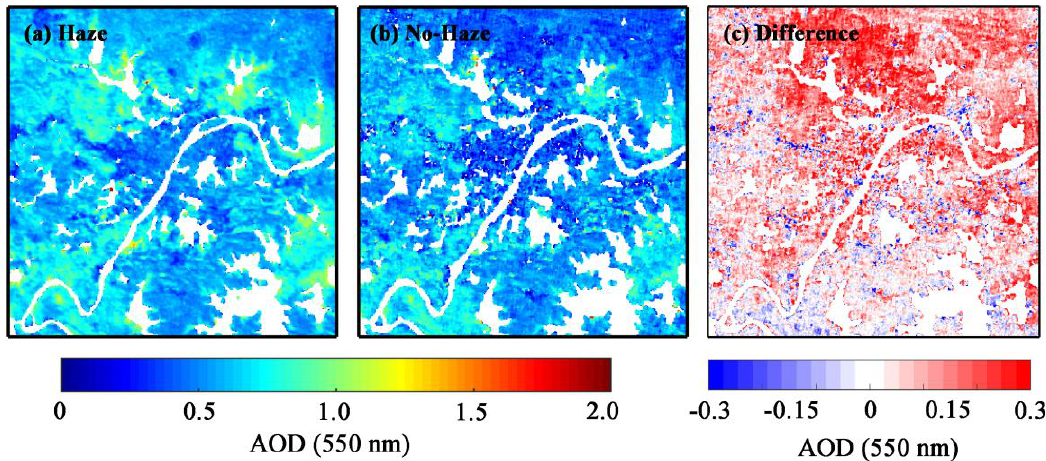
Figure 7. Spatial distributions of average AOD over Wuhan during (a) haze and (b) no-haze conditions. The (c) difference means the haze minus the